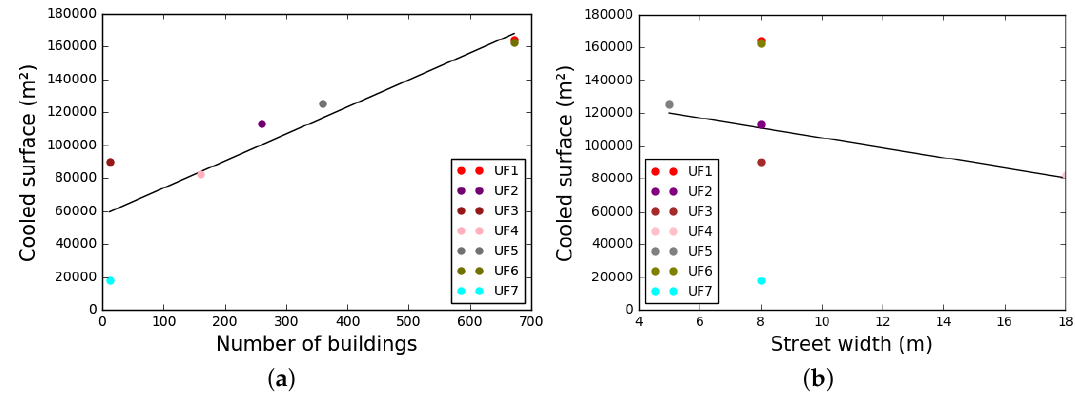
Figure 12. Cooled surface area evolution versus: ( a ) the number of buildings; ( b ) street width—wind speed set at 2.5